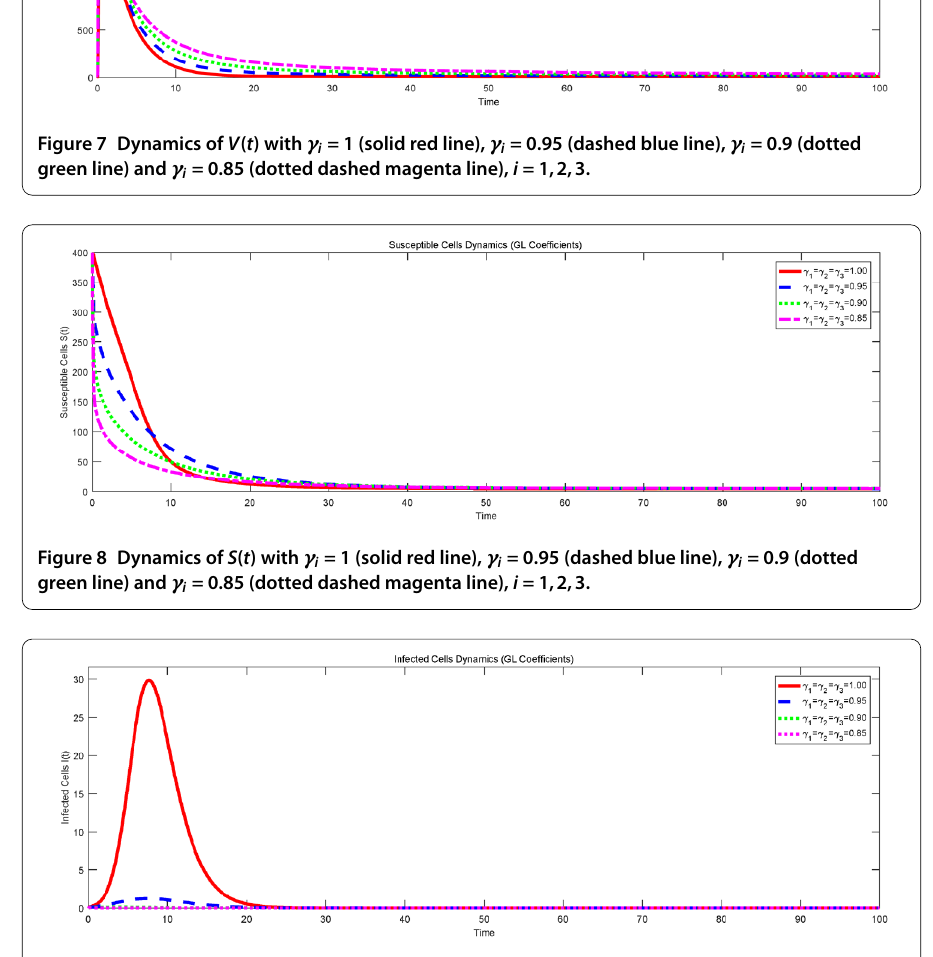
Figure 9 Dynamics of I ( t ) with γ i = 1 (solid red line), γ i = 0.95 (dashed blue line), γ i = 0.9 (dotted green line) and γ i = 0.85 (dotted dashed magenta line), i =